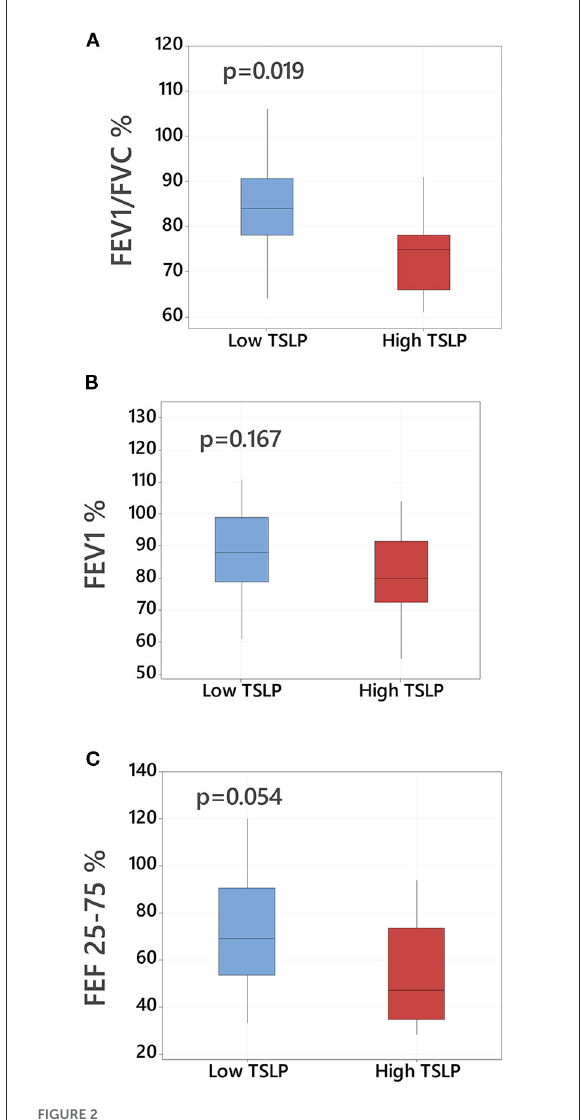
FIGURE2 Lower airway obstruction and baseline TSLP pulmonary levels in asthmatic children. Comparison of lung function parameters in asthmatic children with high TSLP ( ≥ 75th percentile) vs. low TSLP ( < 75th percentile) BAL levels including (A) FEV1/FVC % predicted, (B) FEV1 % predicted and (C) FEF 25–75/% predicted, Data presented as boxplots representing 25th − 75th